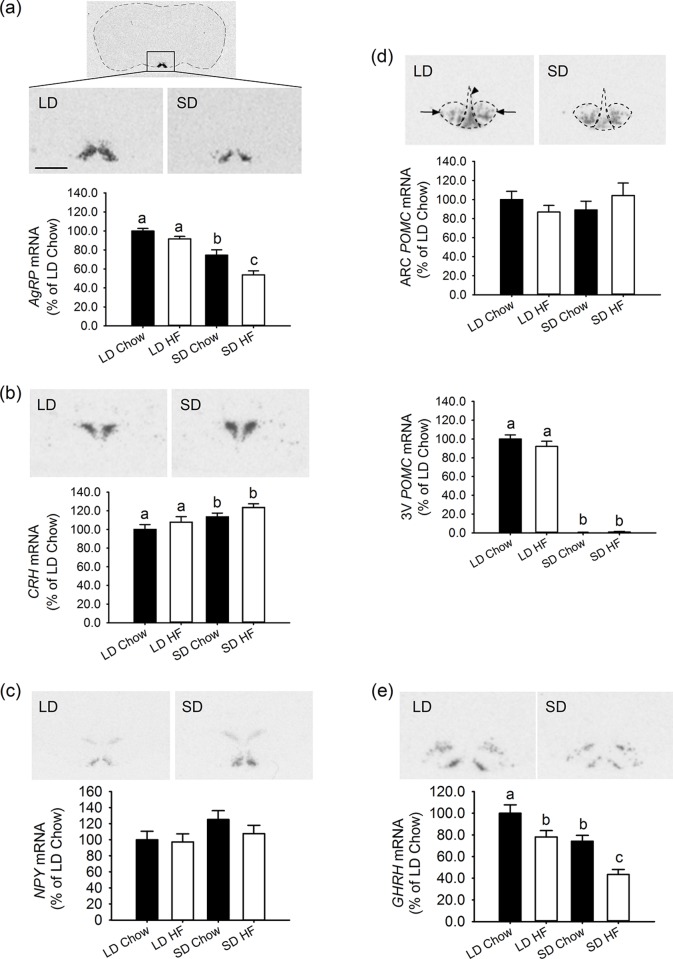
Effect of photoperiod and high fat diet (HFD) on hypothalamic expression of genes involved in energy balance growth in juvenile F344 rats 4 weeks of treatment, measured by quantitative in situ hybridisation.(a) AgRP mRNA expression quantified in the ARC was lower in SD than LD chow fed rats (p<0.001). The HFD had no effect in LD but reduced the AgRP levels further than chow fed rats in SD (p = 0.001). (b) CRH mRNA expression in the PVN was higher in SD than LD chow (p = 0.044) and HFD rats (p = 0.022). The HFD did not impact further on the expression levels in either photoperiod. (c) NPY mRNA levels tended to increase in SD chow fed rats in the ARC but the level did not reach significance (p = 0.119). There were no effects of HFD on NPY expression in either photoperiod. (d) POMC mRNA expression in the ARC is outlined and marked by arrows while atypical POMC expression in the ependymal layer of the 3rd ventricle is marked by an arrowhead. In the ARC, POMC levels were unaffected by photoperiod or diet. In contrast, levels of POMC mRNA were markedly reduced in SD photoperiod (p<0.001) with no additional effects of HFD feeding. (e) GHRH mRNA expression in the ARC was lower in SD than LD chow fed rats. HFD reduced the GHRH expression in LD and even further in SD. Scale bar = 1.0mm for all images.